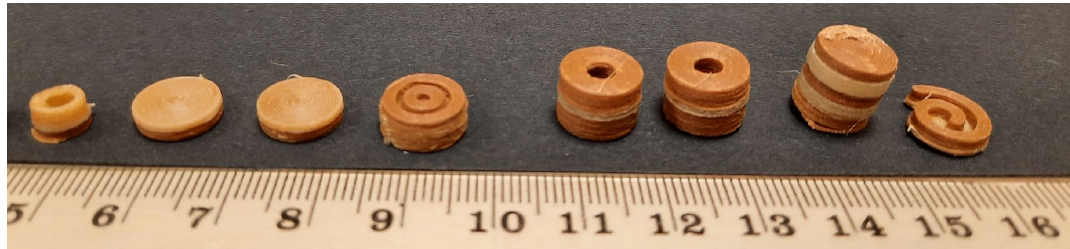
Figure 2. Printed polypills in various designs.